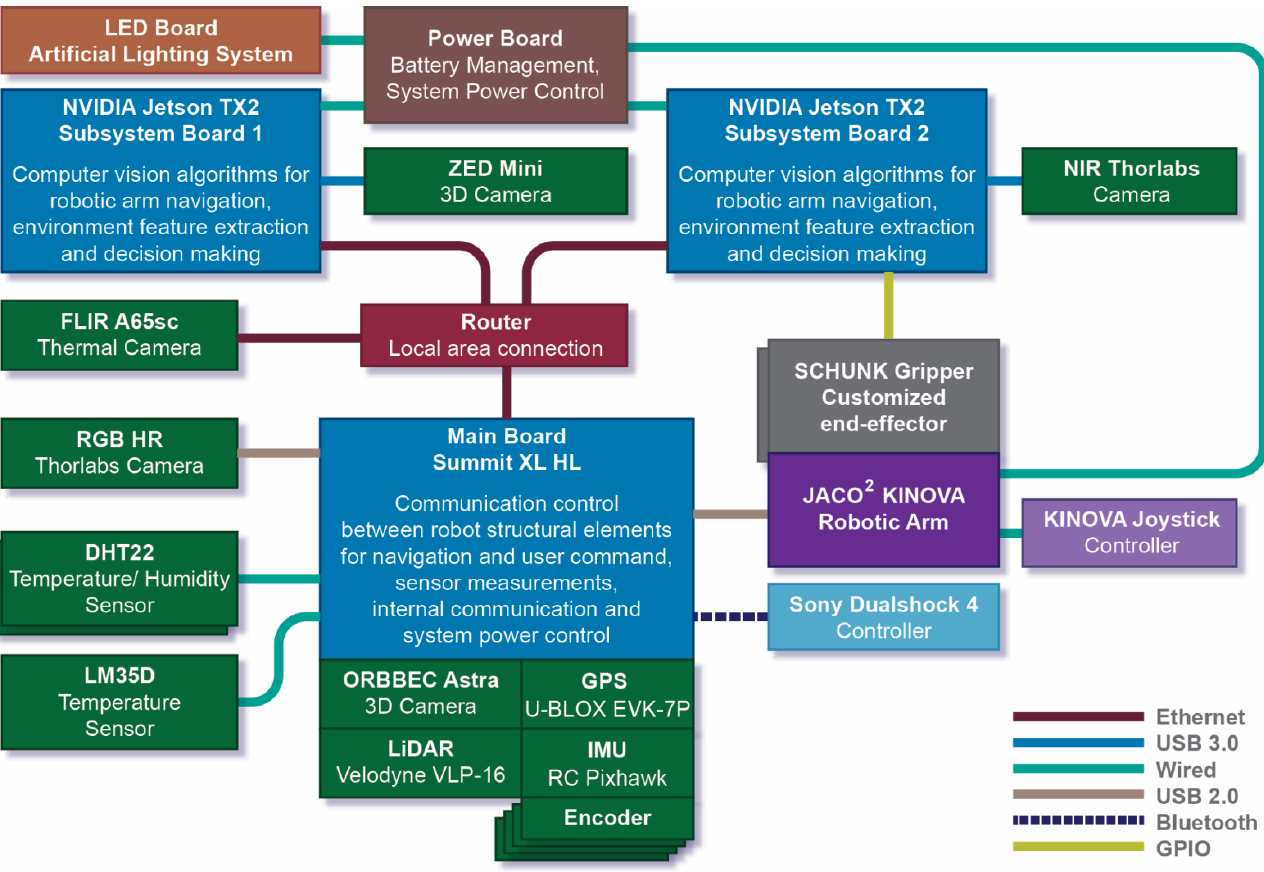
Figure 9. Integration and connectivity of ARG main structure elements.